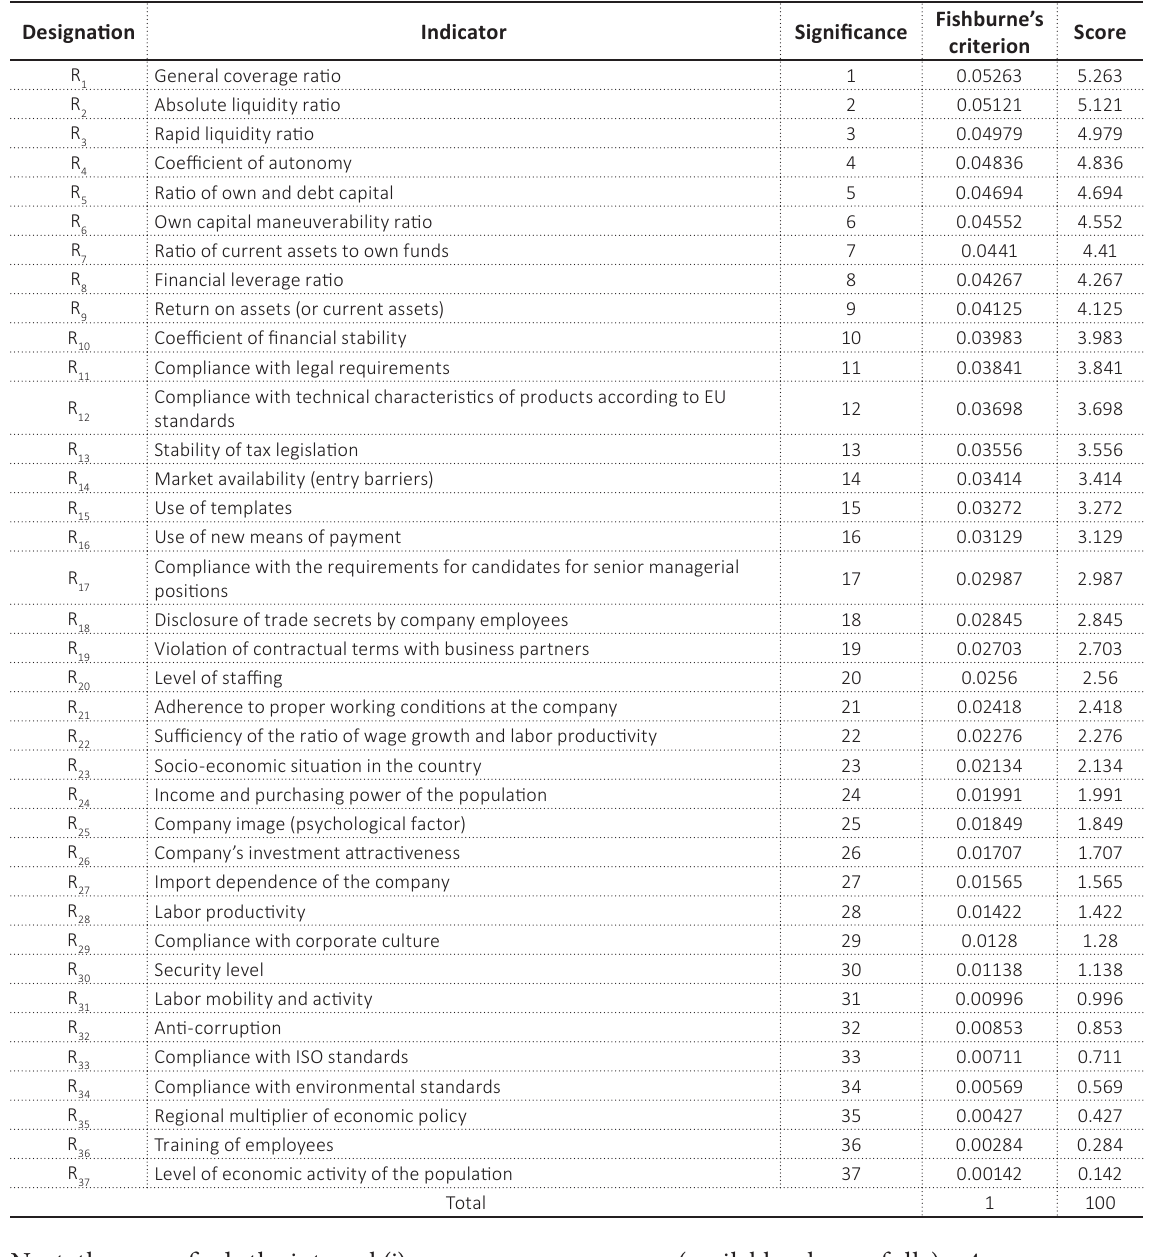
Table 4. Score values of